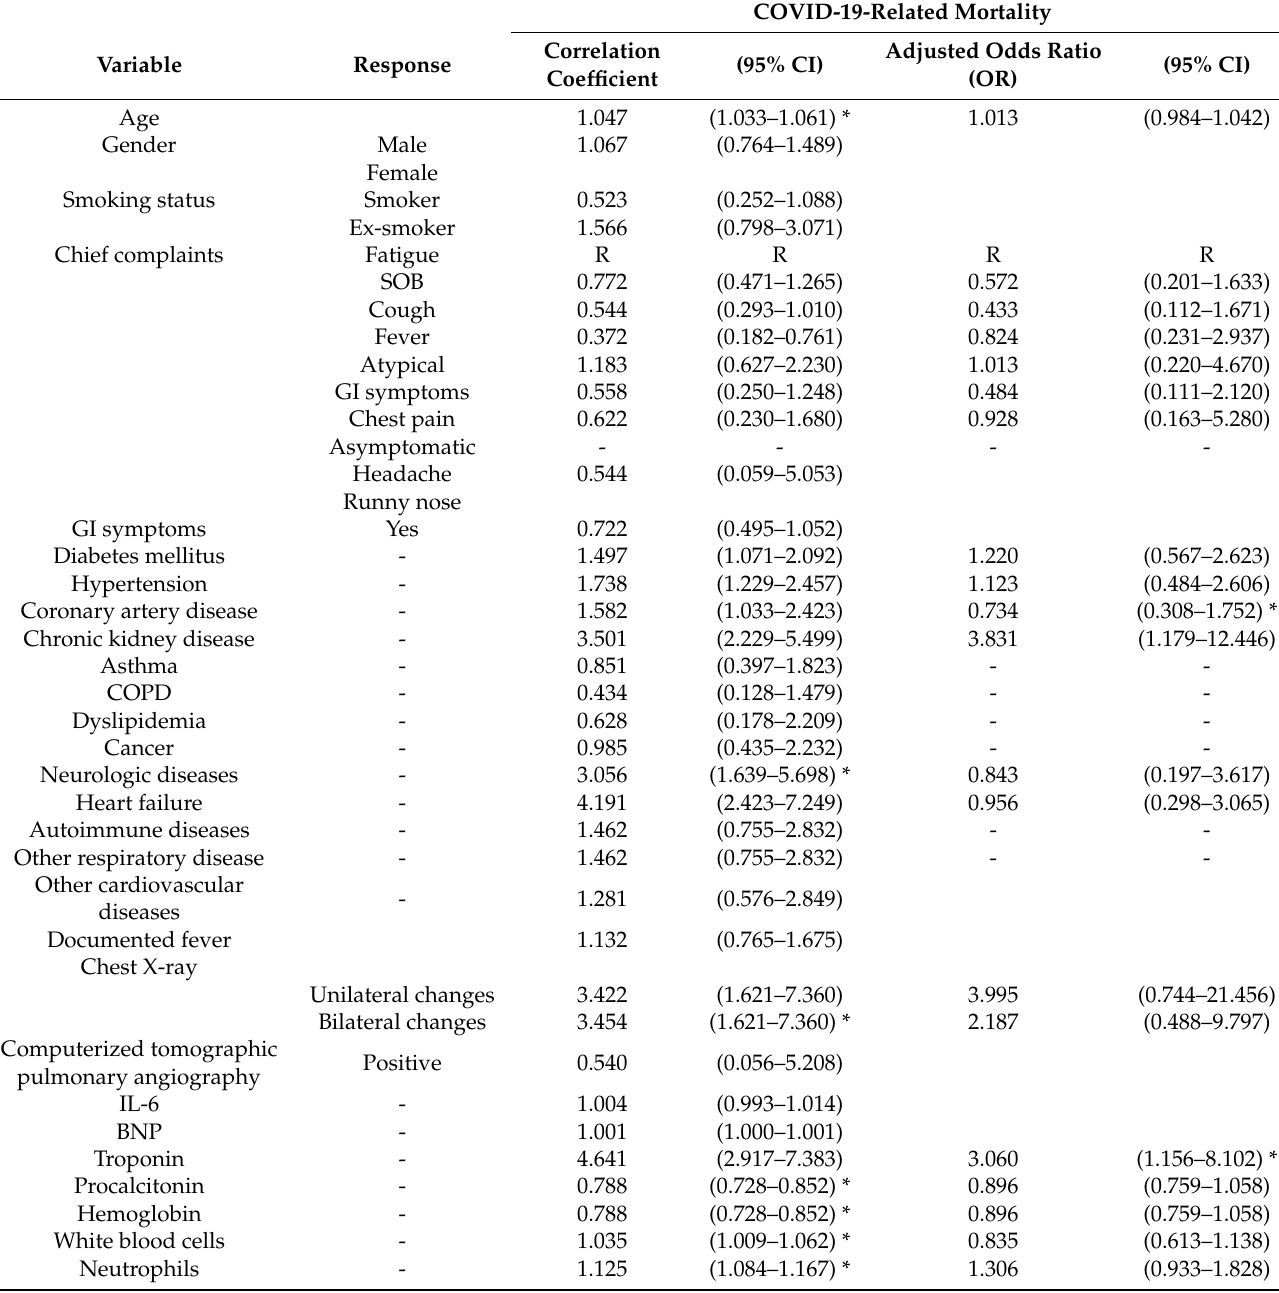
Table 4. Regression Analysis of Predictors of COVID-19-Related Mortality ( n =